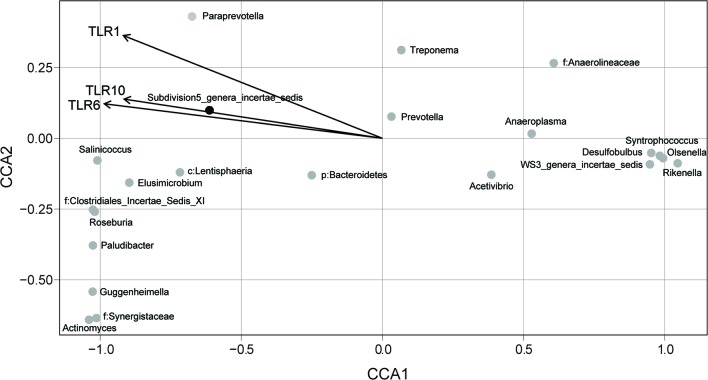
Constrained correspondence analysis revealing the correlations between the abundance of the microbial biomarkers and the expression of the significantly different TLRs (p < 0.05 in t-test).